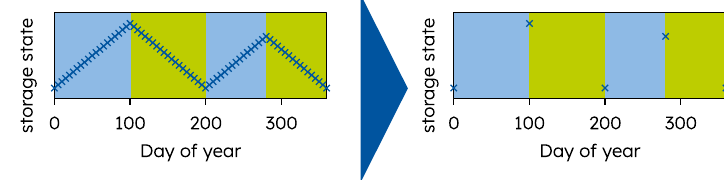
Fig. 2 Explanation of new seasonal storage